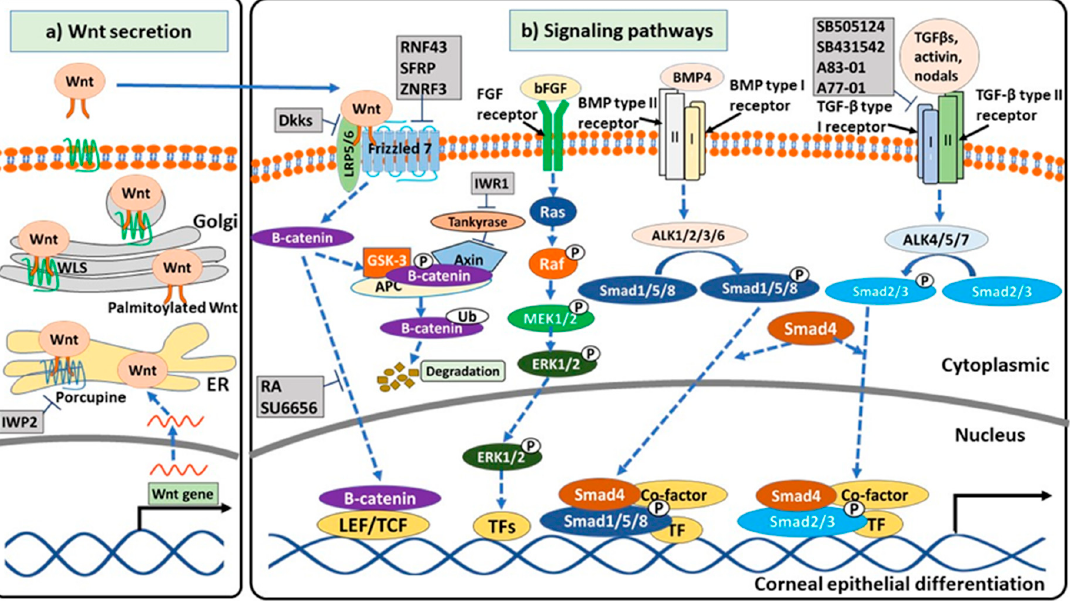
Figure 1. Summary of signaling pathways involved in the differentiation of pluripotent cells into corneal epithelial cells. ( a ) Inhibition of Wnt secretion: IWP2 blocks porcupine, leading to reduction of palmitoylated Wnt protein so Wnt cannot interact with Wntless (WLS) which transports Wnt to plasma membrane; ( b ) Signaling pathways in regulating the corneal epithelial differentiation of pluripotent cells. Firstly, inhibition of Wnt pathway: (1) Blocking initiation of Wnt pathway by blocking Wnt (SFRP), LRP5/6 receptor (Dkks), and Frizzled receptor (RNF43, ZNRF3, SFRP); (2) Increasing degradation of β -catenin by IWR1 lead to block transcription of Wnt target genes; (3) Decreasing translocation of β -catenin from the cytoplasm into cell nucleus by RA, SU6656 leading to